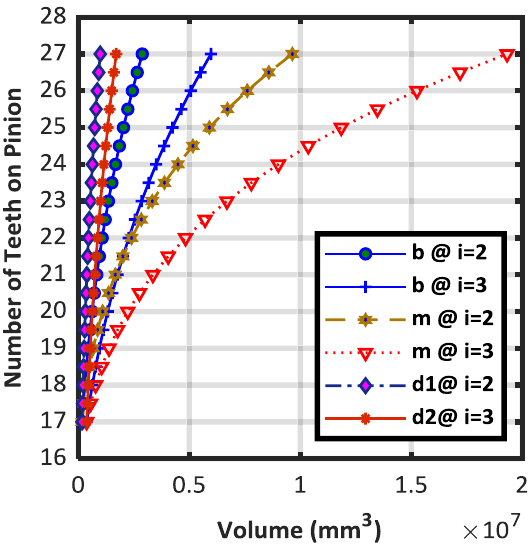
Fig. 14. Volume/ pinion tooth number variation.